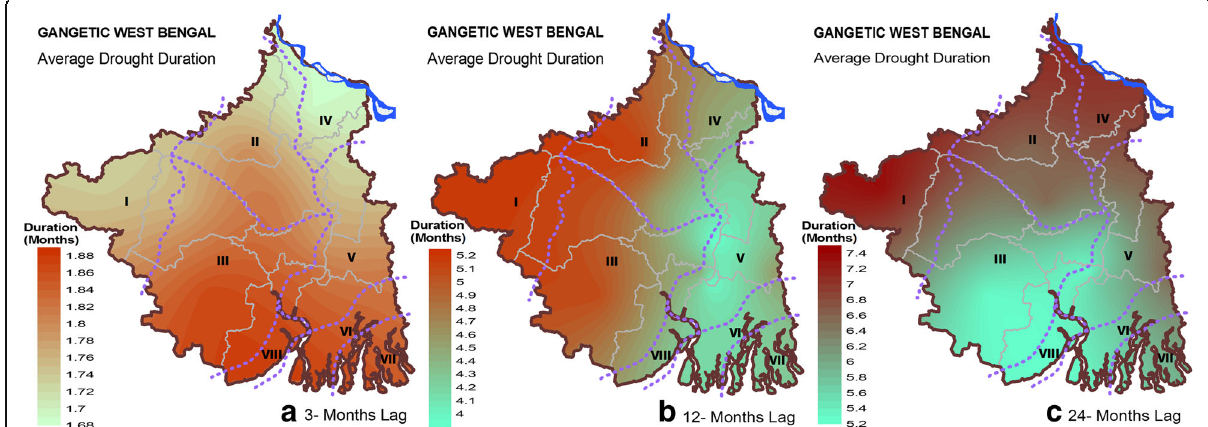
Fig. 7 Average duration of drought events for ( a ) 3-, ( b ) 12-, ( c ) 24- months time